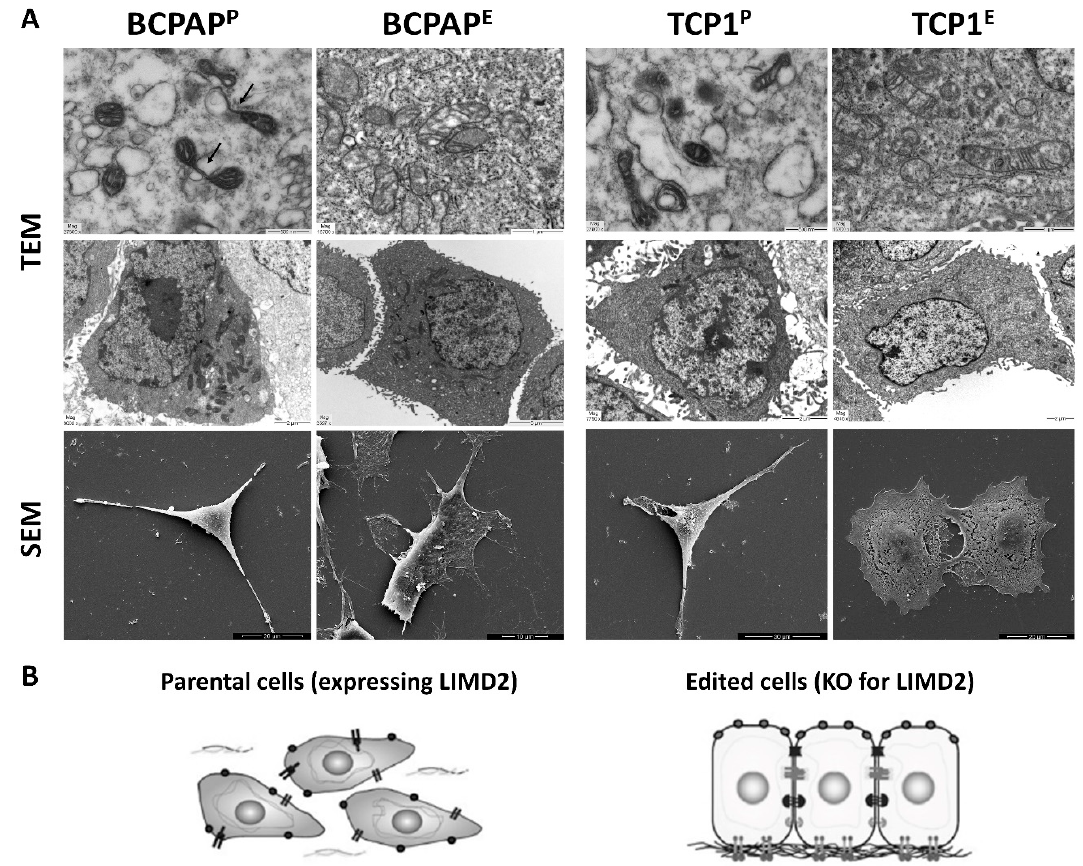
Figure 4. ( A ) Representative images of transmission electron microscopy (TEM) and scanning electron microscopy (SEM). Parental cells (BCPAP P and TPC1 P ) presented loss of apical-basal polarity and concentration of mitochondria in one pole of the cells. The presence of small and circular mitochondria suggests mitochondrial fission. Vacuoles and mitochondrial fission are showed (arrow). Remarkably, the apical-basal polarity and mitochondria morphology are somewhat restored in LIMD2-edited cells (BCPAP E and TPC1 E ); ( B ) Schematic model of parental (expressing LIMD2) and edited cells (complete KO of LIMD2).